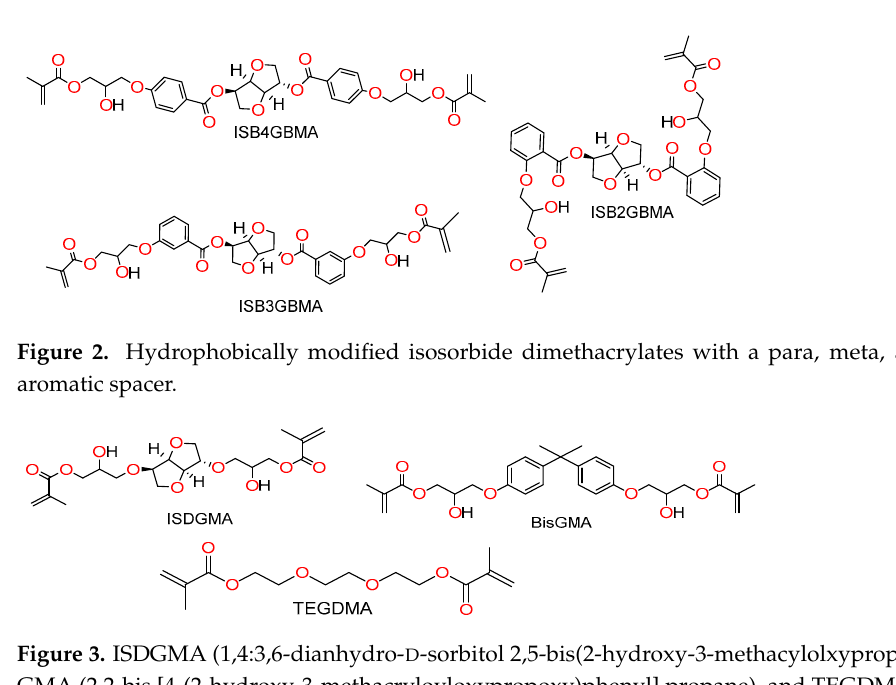
Figure 2. Hydrophobically modified isosorbide dimethacrylates with a para, meta, and ortho aro- matic spacer.